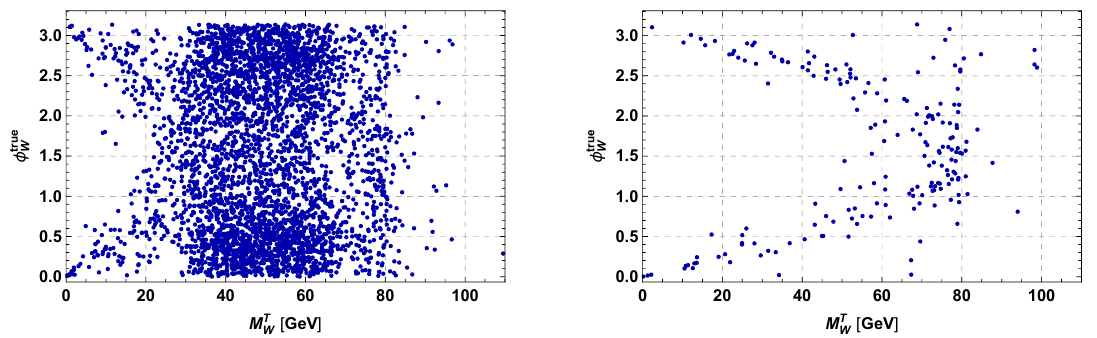
Figure 6 . Distribution of the azimuthal angle (cid:30) W vs transverse mass of the W bososn M T | no other cuts are imposed, right additional cut on the p (cid:13)